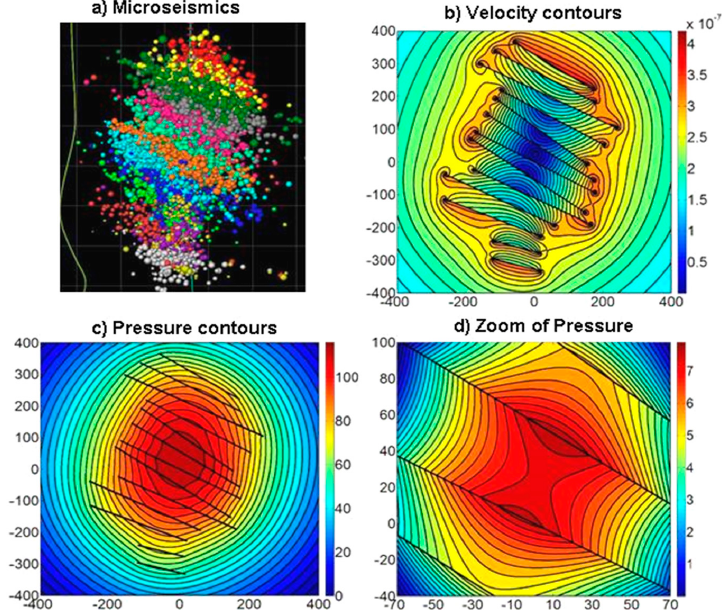
Figure 9. ( a ) Map view of imaged seismic events centered about a horizontal well during fracking of each stage (individual color bands). Adjacent seismic imaging well is highlighted (olive green) in left of image. ( b ) Velocity field (m/s) in after 1 month of well-life; field dimensions in m. ( c ) Pressure change (MPa) relative to the original reservoir pressure. ( d ) Detailed pressure gradient map of central region of the fracked well.